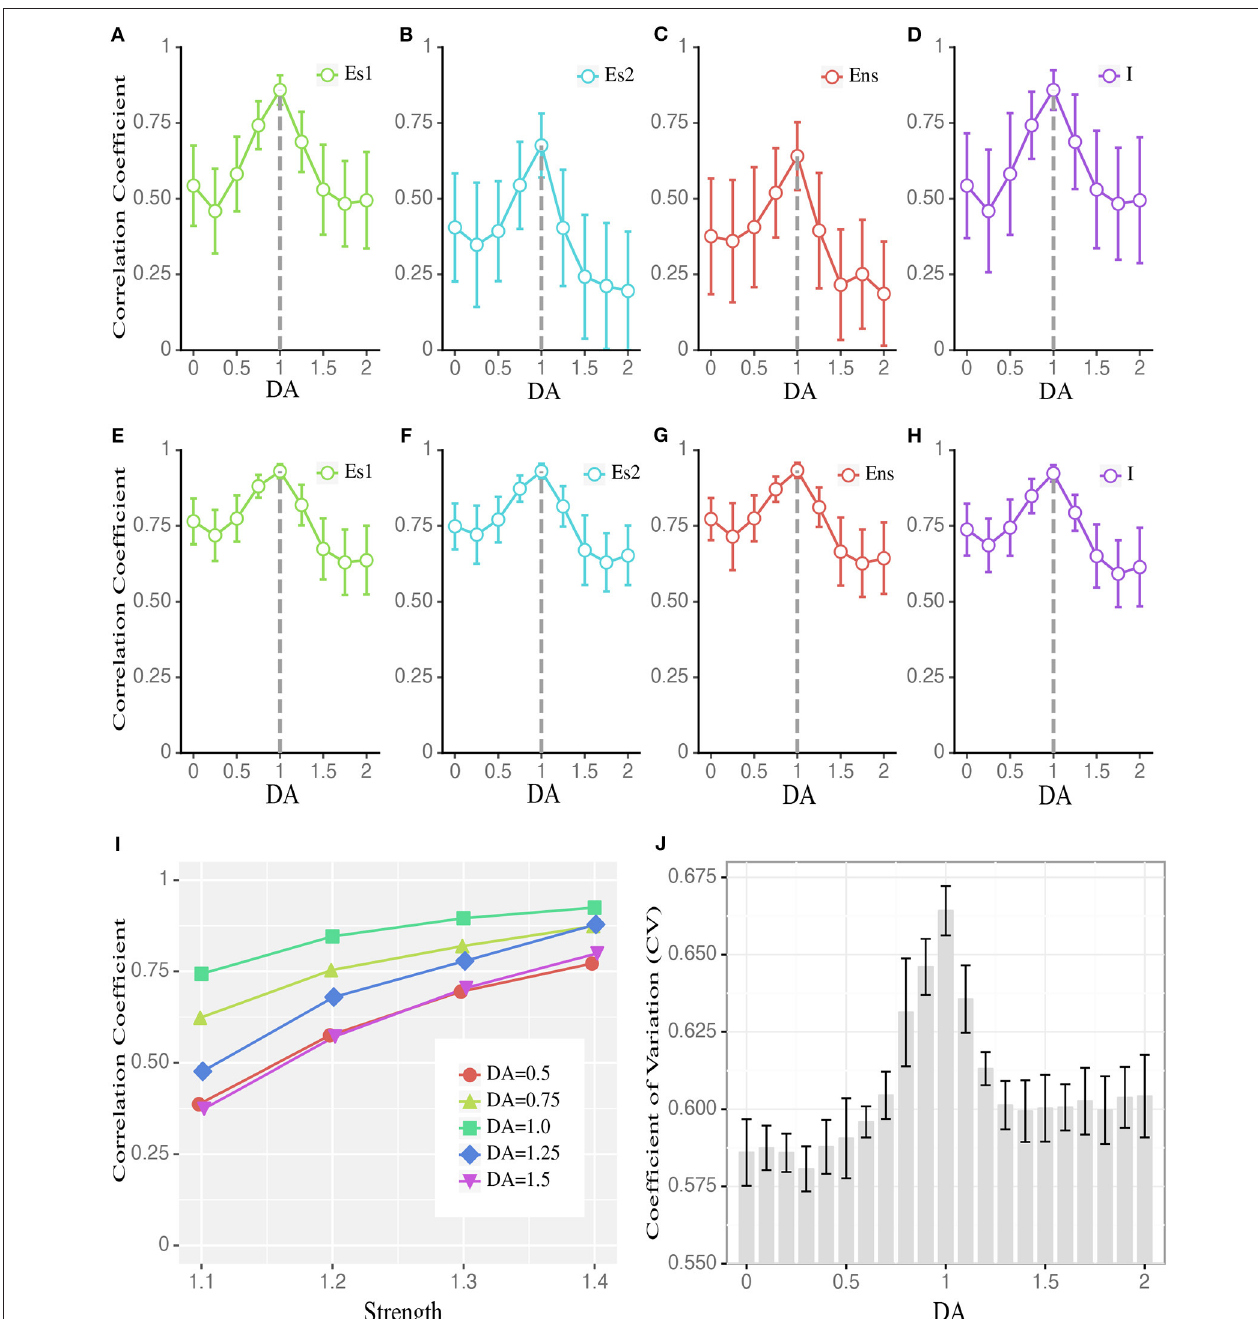
FIGURE 4 | Dopamine modulates the balance between excitatory and inhibitory currents to individual neurons. (A–D) The average correlation coefficient of excitatory and inhibitory currents received by individual neurons in different populations during stimulus presentation, including stimulus-targeted selective population (E s1 ), Es population without stimulation (results for E s2 are shown as an example), non-selective population (E ns ), and inhibitory population (I). Data are means corresponding population. (E–H) Similar to (A–D) but the correlation coefficient is computed based on only recurrent currents, excluding external inputs and leaky currents. (I) The correlation coefficient of E s1 (to save space, E s2 , E ns , and I are omitted.) in (A) increases with stronger stimulation strengths. DA with the largest correlation across all strengths. For visual clarity, only the means of the correlation coefficients across the corresponding population are shown. (J) CV (coefficient of variation) of the inter-spike interval changes as a function of DA modulation, with DA mean S.D. across fifteen trials at each DA level). The group differences between low, high, and intermediate DA in (A–J) are statistically significant (one-way ANOVA ± with multiple comparison tests under Tukey’s criterion, p < 0.05).